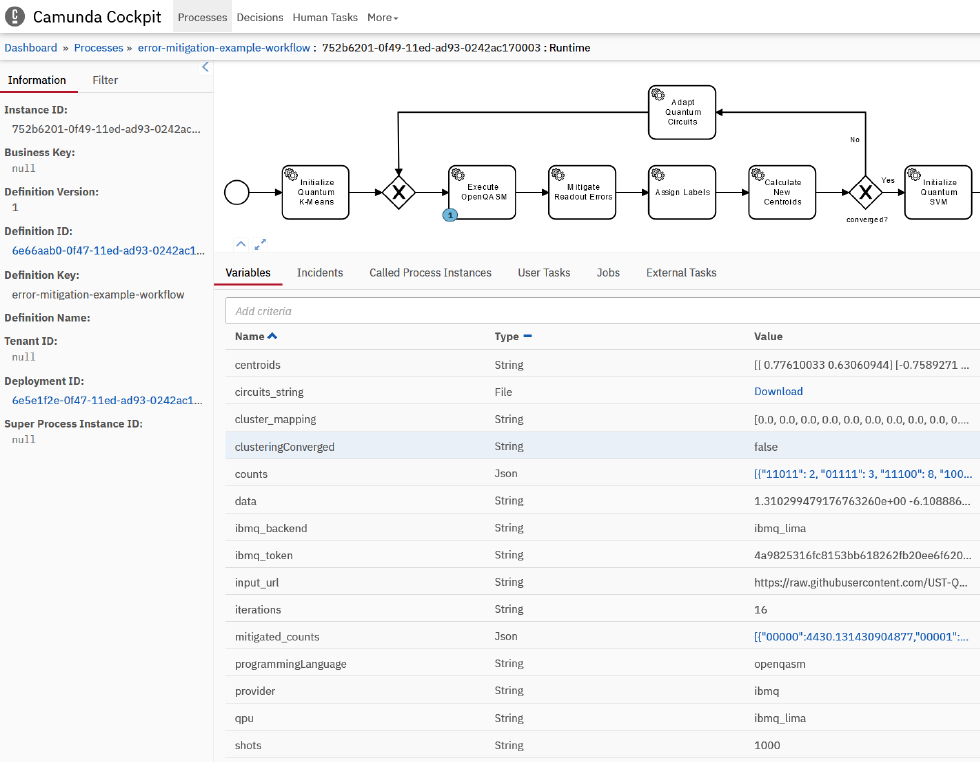
Figure 10. Overview of the case study’s workflow execution in the Camunda user